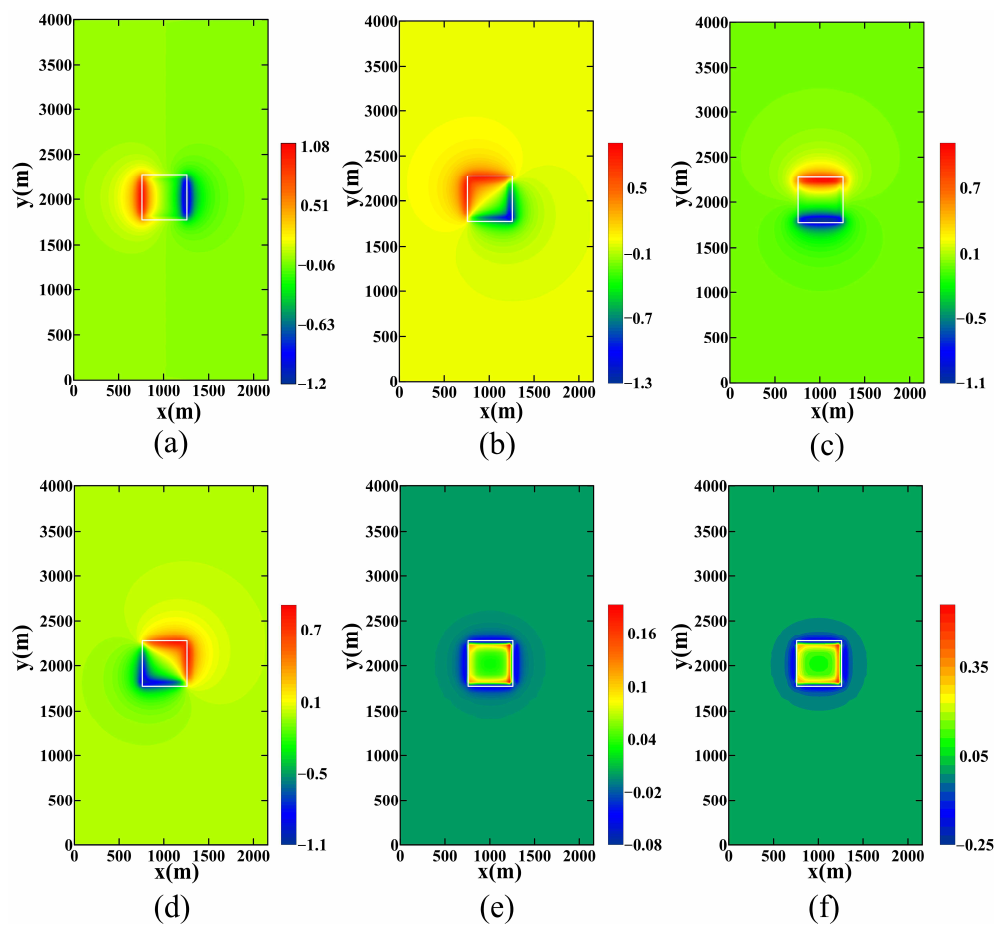
Figure 5. Results of different filter methods. ( a ) E direction; ( b ) S−E direction; ( c ) S direction; ( d ) SW direction; ( e ) the second−order derivative of Laplacian 1; ( f ) the second−order derivative of Laplacian 2.